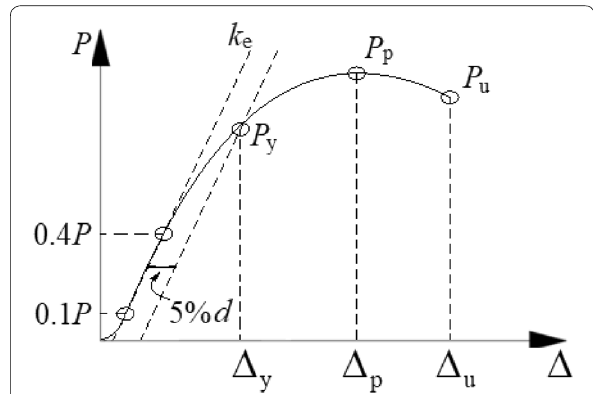
Fig. 7 Definitions of the main mechanical property